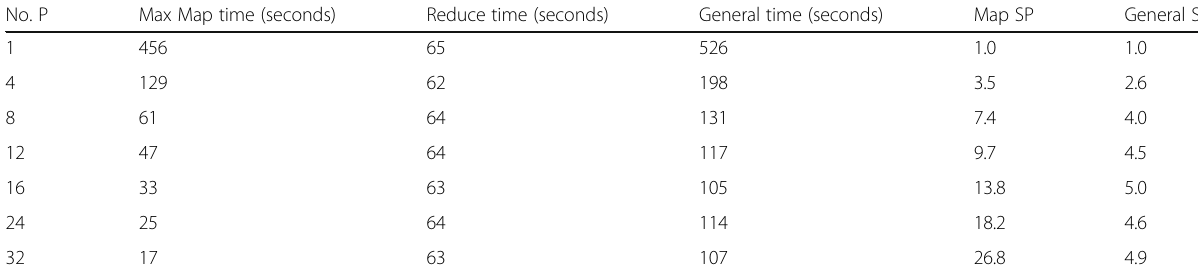
Table 3 The test results of a 2-GB file on different cores No. P